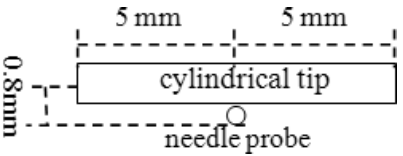
Fig. 3. The positions of the needle probe in relationship with the interstitial ¯ber